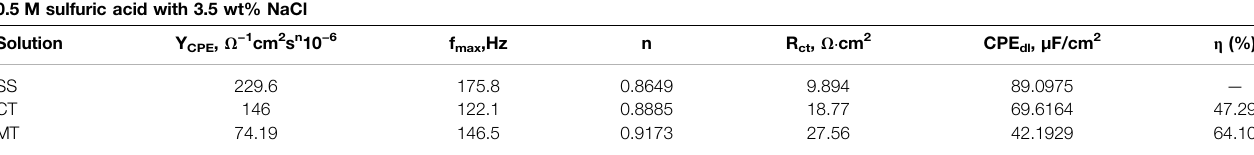
TABLE 1 | Fitting results of obtained Nyquist and Bode plots by exposing Q235 steel to acidic 3.5 wt% NaCl solution without or with mangrove tannins. 0.5 M sulfuric acid with 3.5 wt%